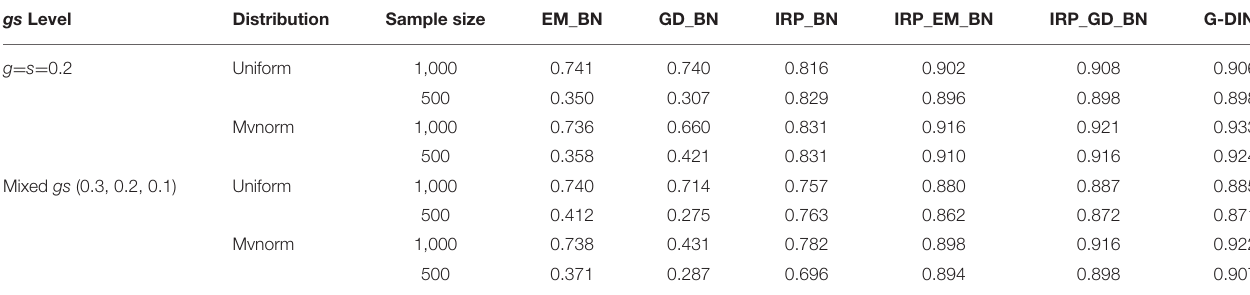
TABLE 5 | The AACR of BNs and G-DINA from the data generated by G-DINA. gs Level Distribution Sample size EM_BN GD_BN IRP_BN IRP_EM_BN IRP_GD_BN G-DINA g = s = 0.2